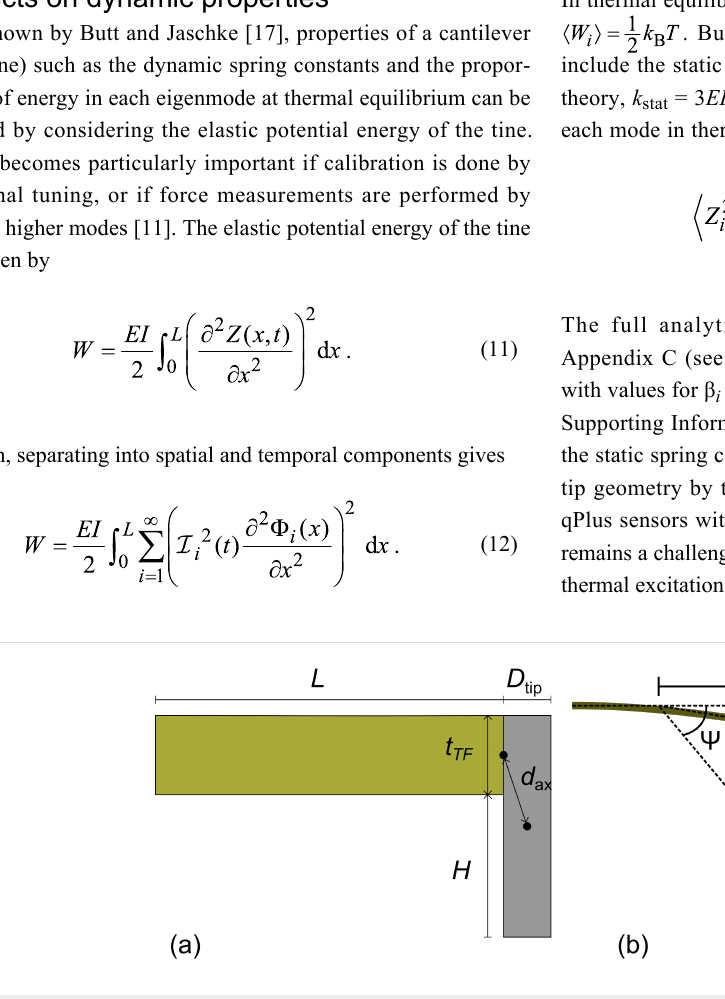
Figure 1: (a) Diagram of theoretical model. d ax is the distance from the centre of mass of the tip to the axis of tip rotation. The tine of the tuning fork is assumed to be clamped at the left-hand side. (b) Geometrical diagram of the tip motion as the cantilever deforms. Note the two ψ angles are not iden- tical in this diagram as θ is too large due to the exaggerated amplitude of deflection, a z